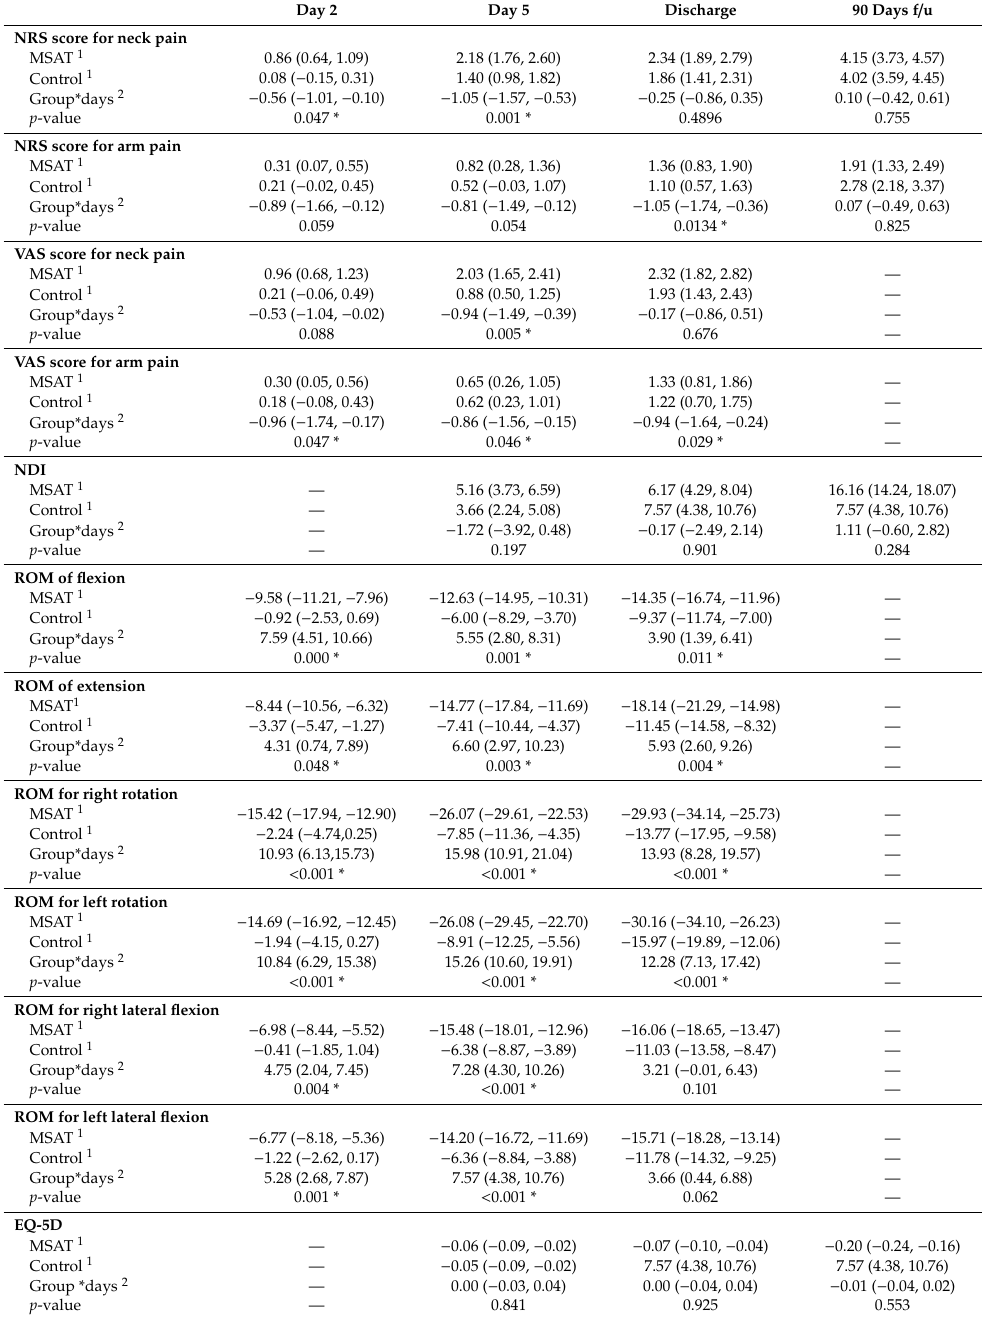
Table 3. Comparison of changes in outcome from baseline at each measuring point between the MSAT and control